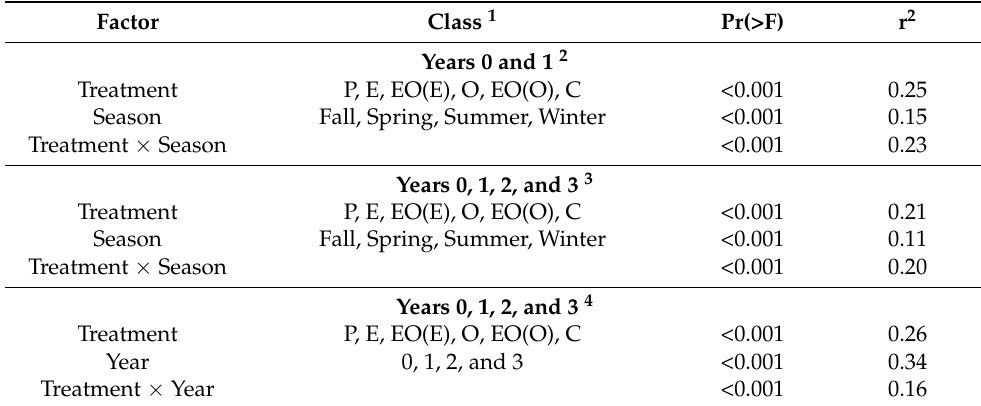
Table A4. perMANOVA based on Bray–Curtis dissimilarity metric on abundance of taxa collected during suction sampling at San